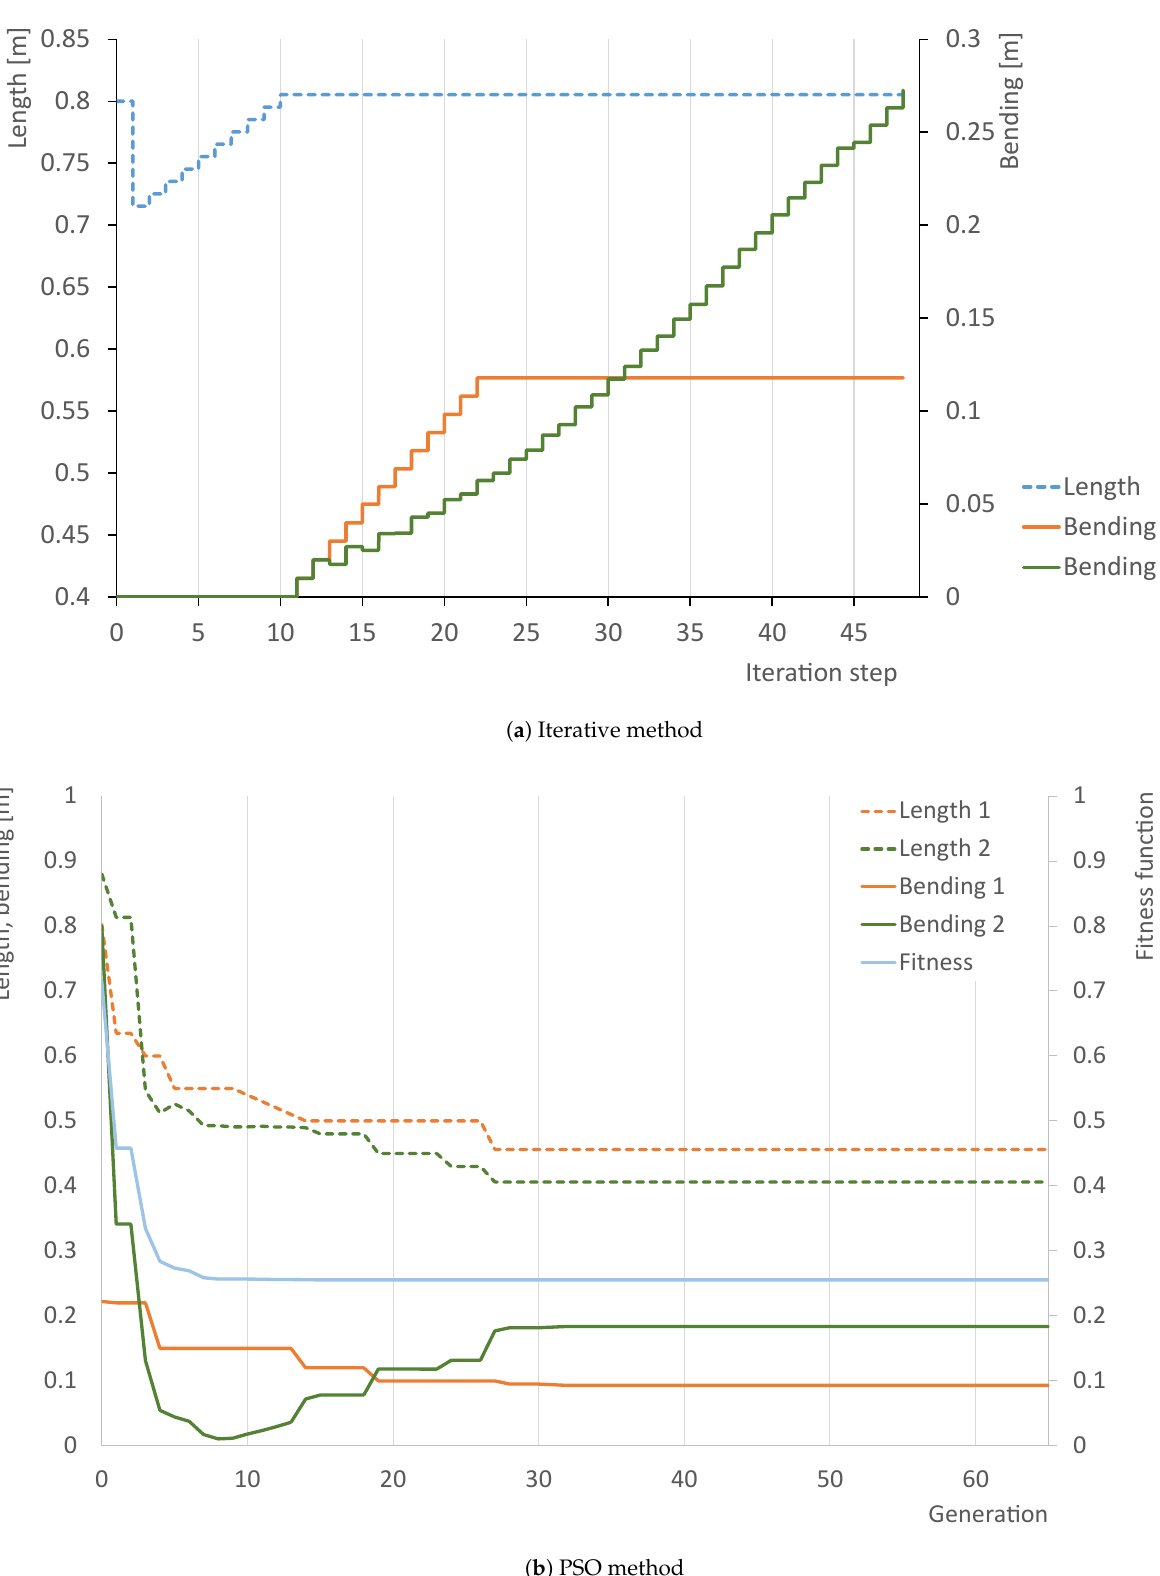
Figure 13. Graphs for the second testing workplace. ( a ) Modifications made to the robot structure in individual iteration steps during the optimization algorithm (the sums of arm lengths and individual lower and upper arm bending amounts are shown). ( b ) Selected parameters of the best particle with the PSO algorithm (the lower and upper arm lengths and bending amounts and the fitness function value are